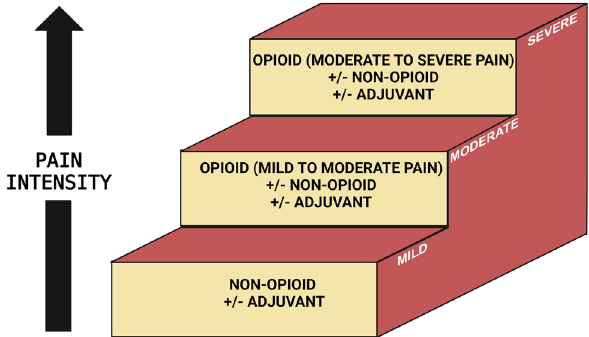
Fig. 3 World Health Organi- sation 3-step analgesic ladder for the management of cancer-related pain [76]. (Cre- ated with